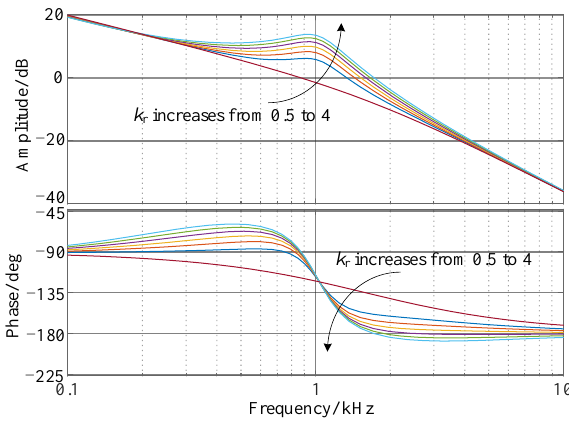
Figure 11. The bode plot of G i_ol ( s ) with resonance controller under different k r .